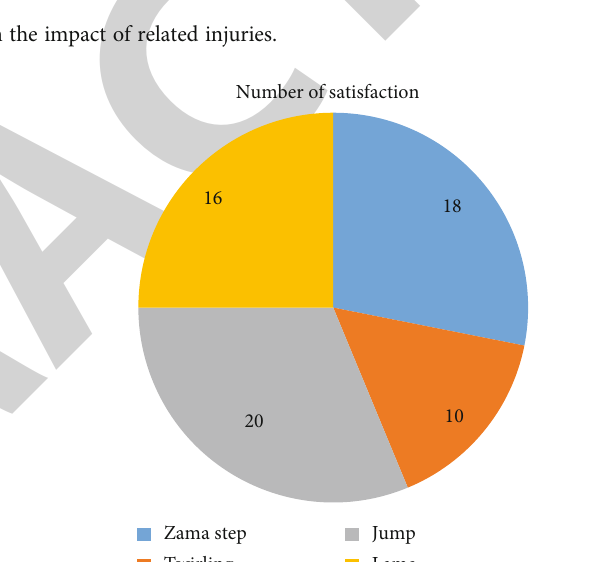
Figure 1: Related actions on the impact of related injuries.